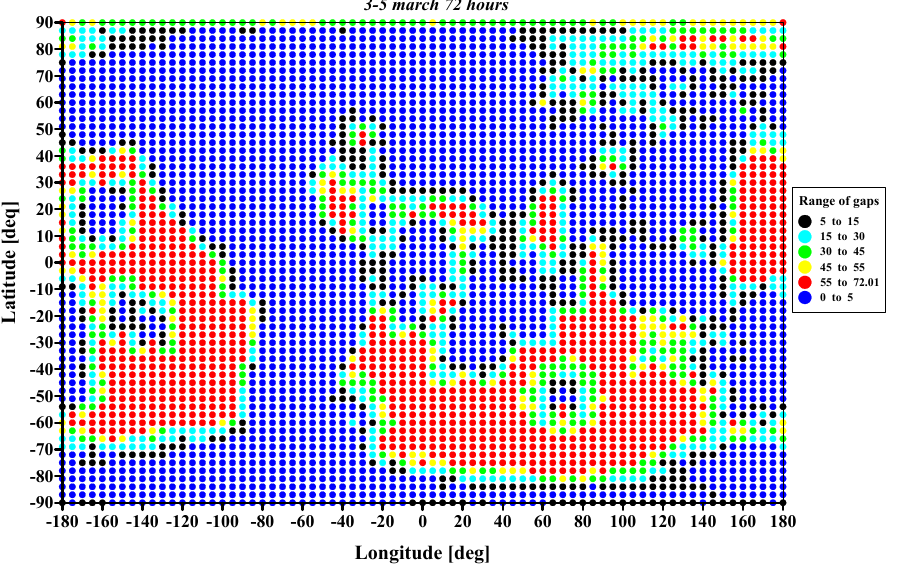
Figure 2. Global distribution of the number of gaps in the Madrigal data.